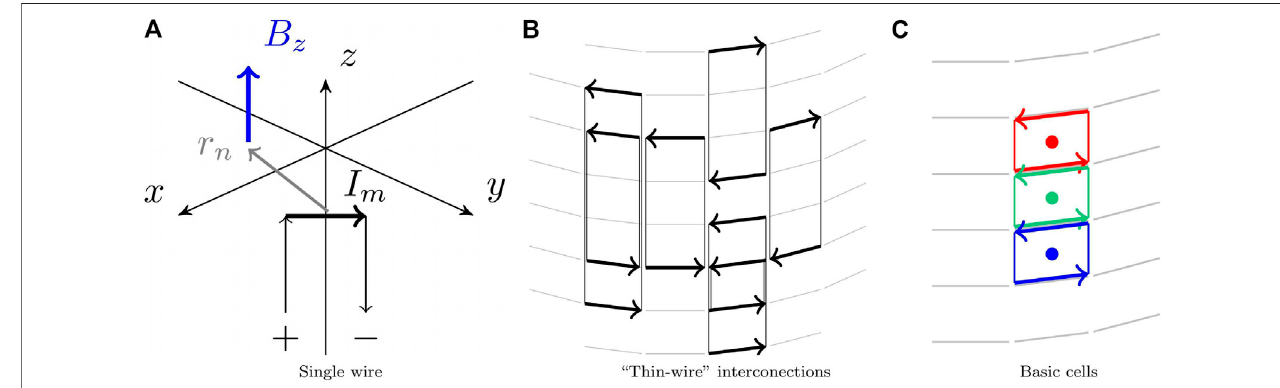
FIGURE1|(A) Onecurrentcarryingelementwhichhostsacurrent I m generatesamagnetic fi eldcomponent B z atposition r n .Multiplediscretethinwireswhichare orientedorthogonaltothedirection ofthemain magnetic fi eld, z ,may beused toapproximate acurrentdensity, J ,onaregular surface. (B) Acoildesign mayberealized withclosedloopsifthereisareturnpathforeachcurrent fl owingalong z . (C) Abasicrectangularcellofaboundaryelementisde fi nedbycombiningtwoneighboringthin- wire elements with opposite current directions. Each color depicts one basic cell. If only B z is considered this cell is composed of two parallel wires.